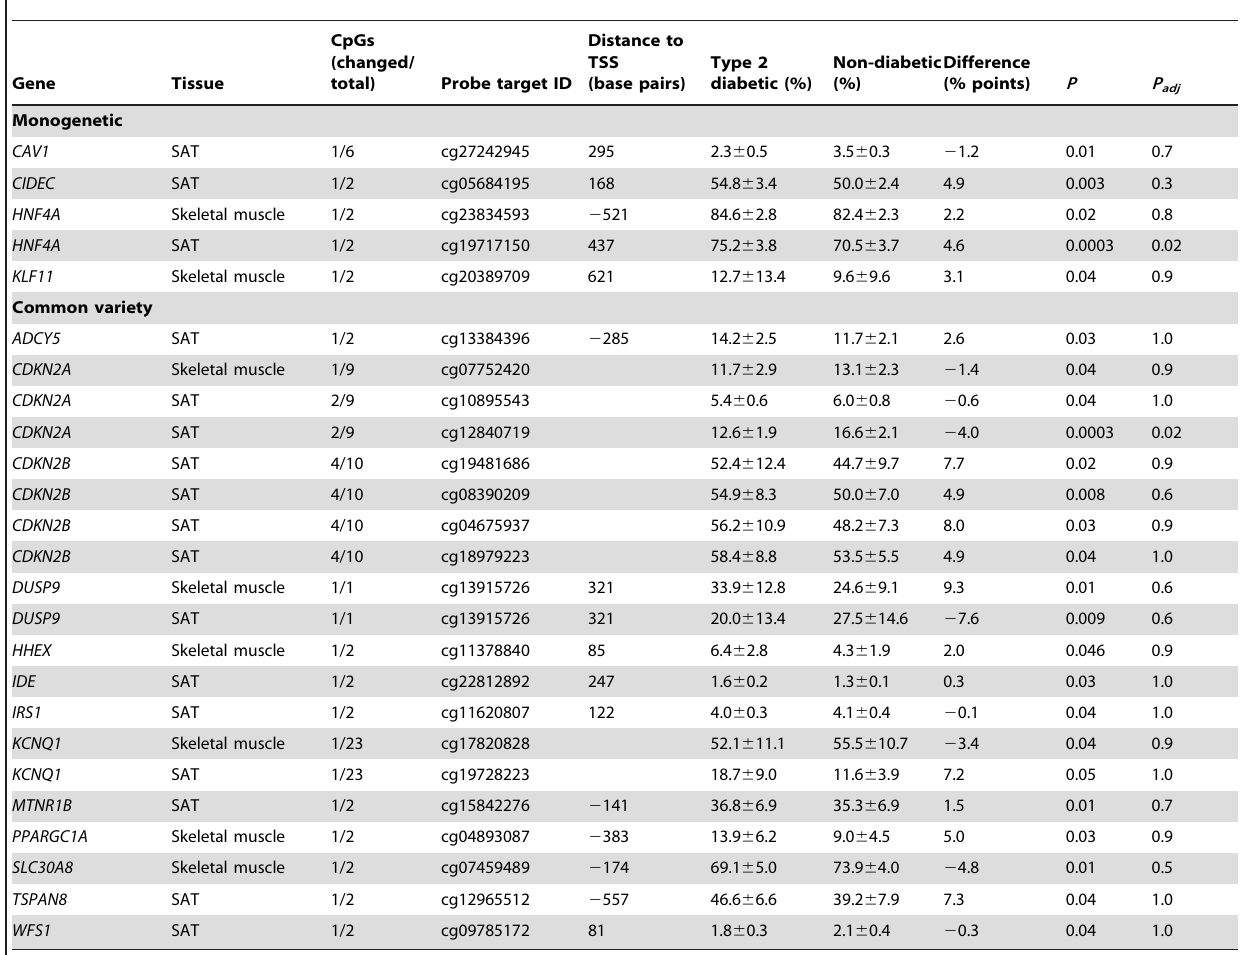
Table 2. Differentially methylated type 2 diabetes susceptibility